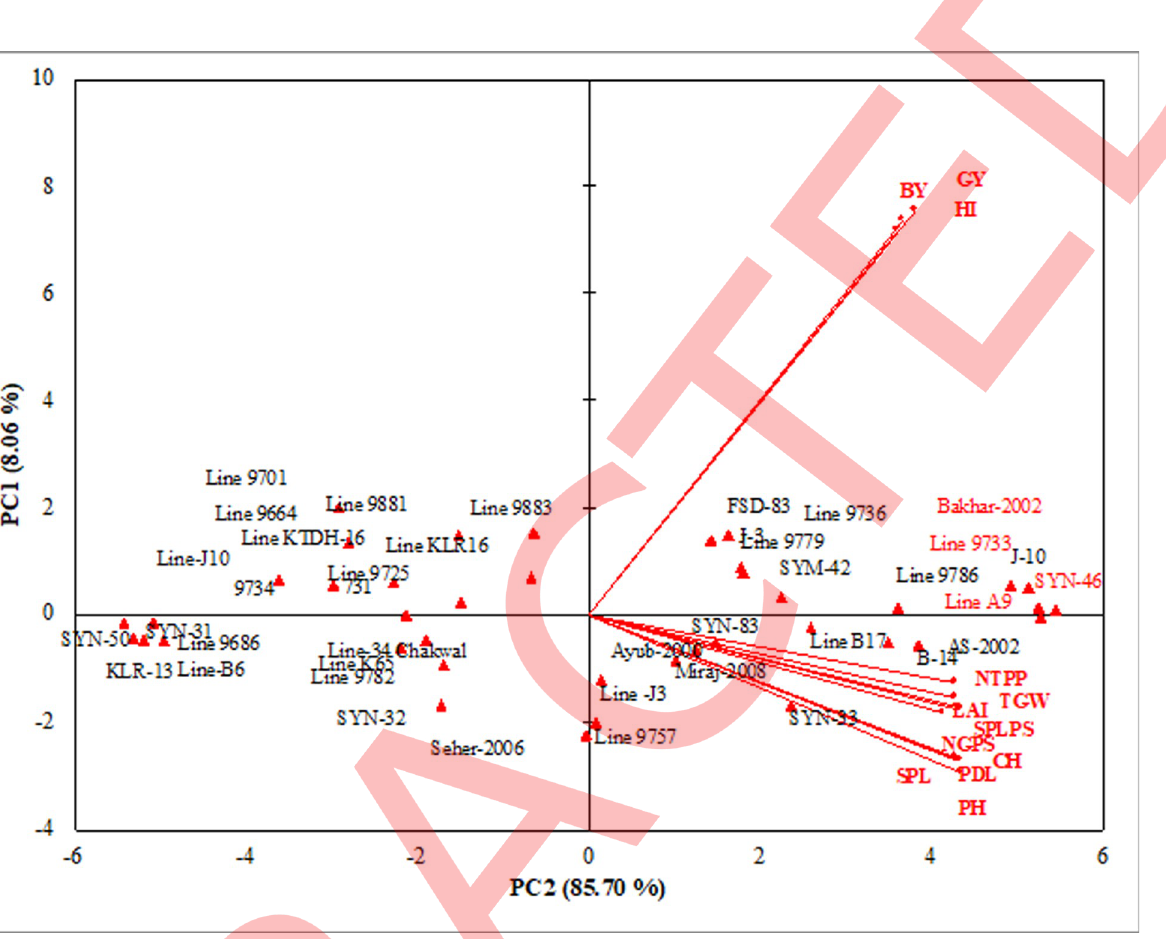
Fig 1. Biplot of first two principal components resulting from the principal component analysis executed on different growth and yield- related traits of forty different wheat genotypes included in the study. Here, PH = plant height, PDL = Peduncle length, NTPP = number of tillers per plant, LAI = leaf area index, CH = chlorophyll index (SPAD value), SPL = spike length, SPLPS = number of spikelets per spike, NGPS = number of grains per spike, TGW = 1000-grain weight, GY = grain yield, BY = biological yield, HI = harvest index.